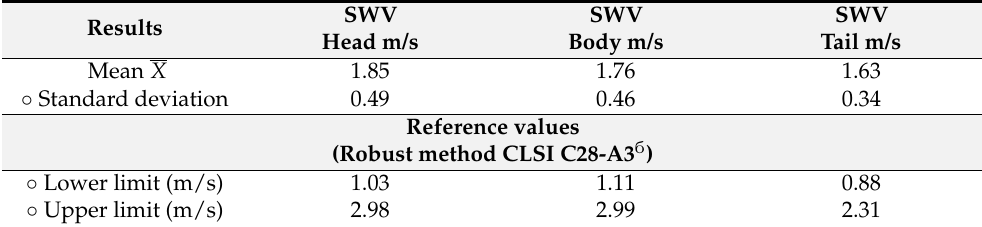
Table 3. SWV values in the CP group.